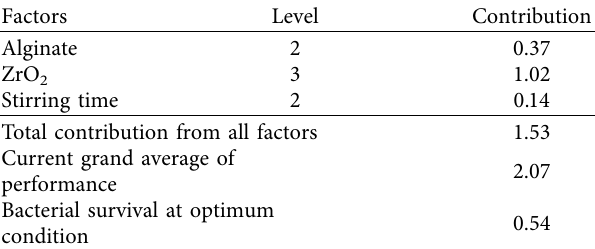
DOF, degree of freedom. Table 5: Te optimum conditions for the synthesis of alginate/ zirconia nanocomposites with the highest antibacterial activity.